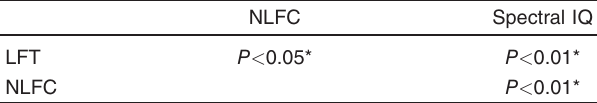
Table 6 Pairwise comparisons by Tukey honest significant difference test at 1000 and 2000, and 4000 Hz